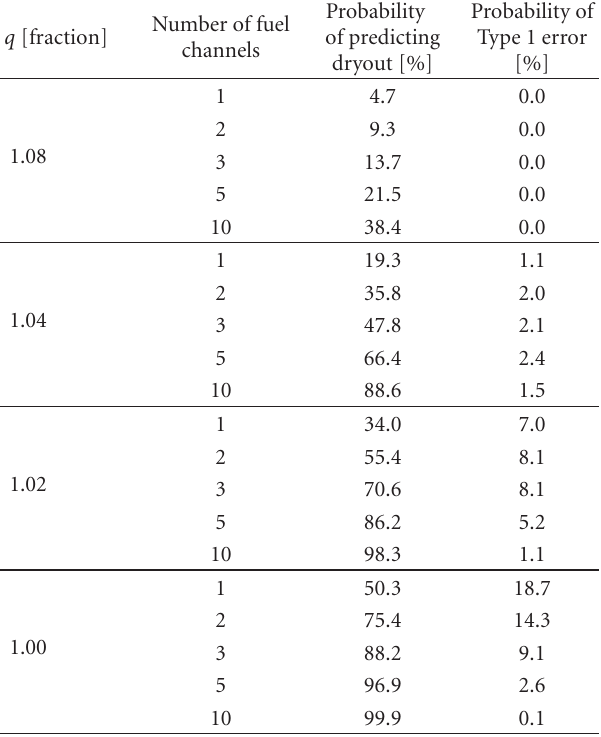
Table 1: Influence of the number of participating fuel channels in the probability of missing